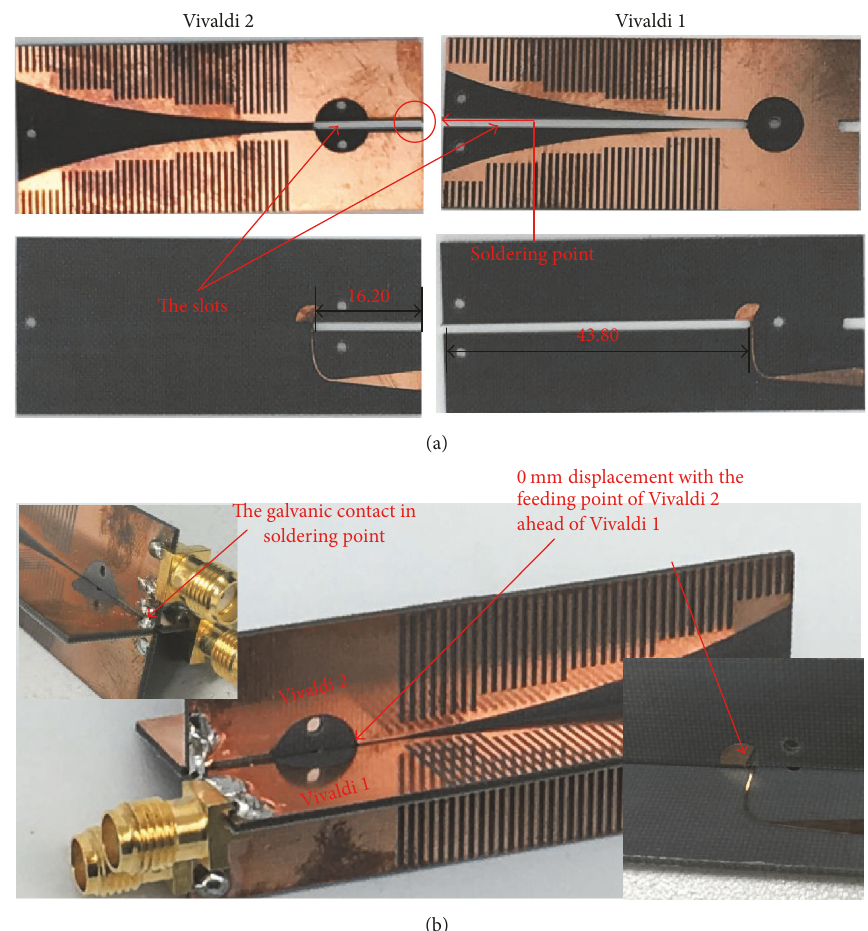
Figure 8: Photograph of (a) top and bottom view for Vivaldi elements: Vivaldi 1 and Vivaldi 2; (b) modified dual-polarized Vivaldi antenna.